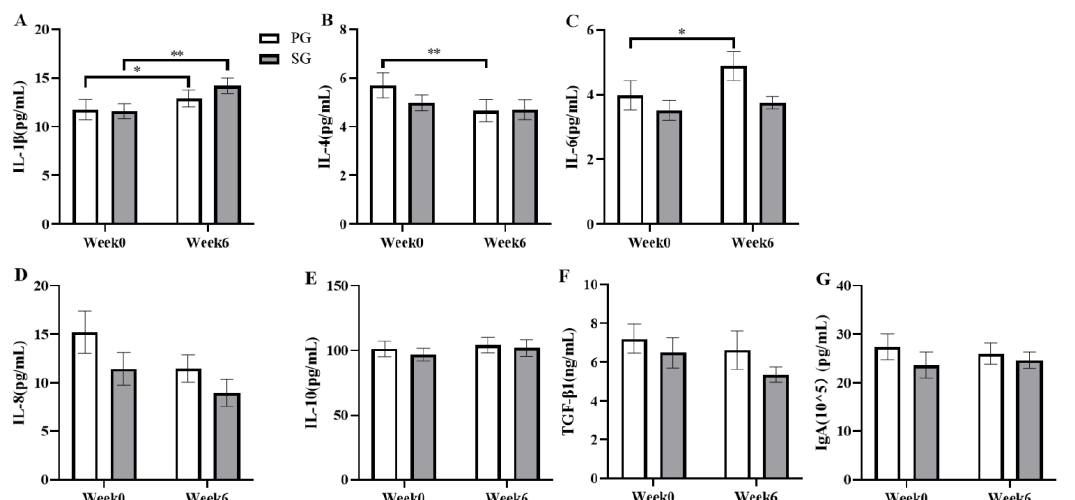
Figure 4. Comparison of the effects of the prebiotic and synbiotic on serum cytokine concentration at basal status in elite football players. Results are presented as mean ± SEM. PG: prebiotic group (n = 15); SG: synbiotic group (n = 15). ( A ) IL- 1β concentration. ( B ) IL-4 concentration. ( C ) IL-6 concentration. ( D ) IL-8 concentration. ( E ) IL-10 concentration. ( F ) TGF- β1 concentration. ( G ) IgA concentration. *: p < 0.05; **: p < 0.01.